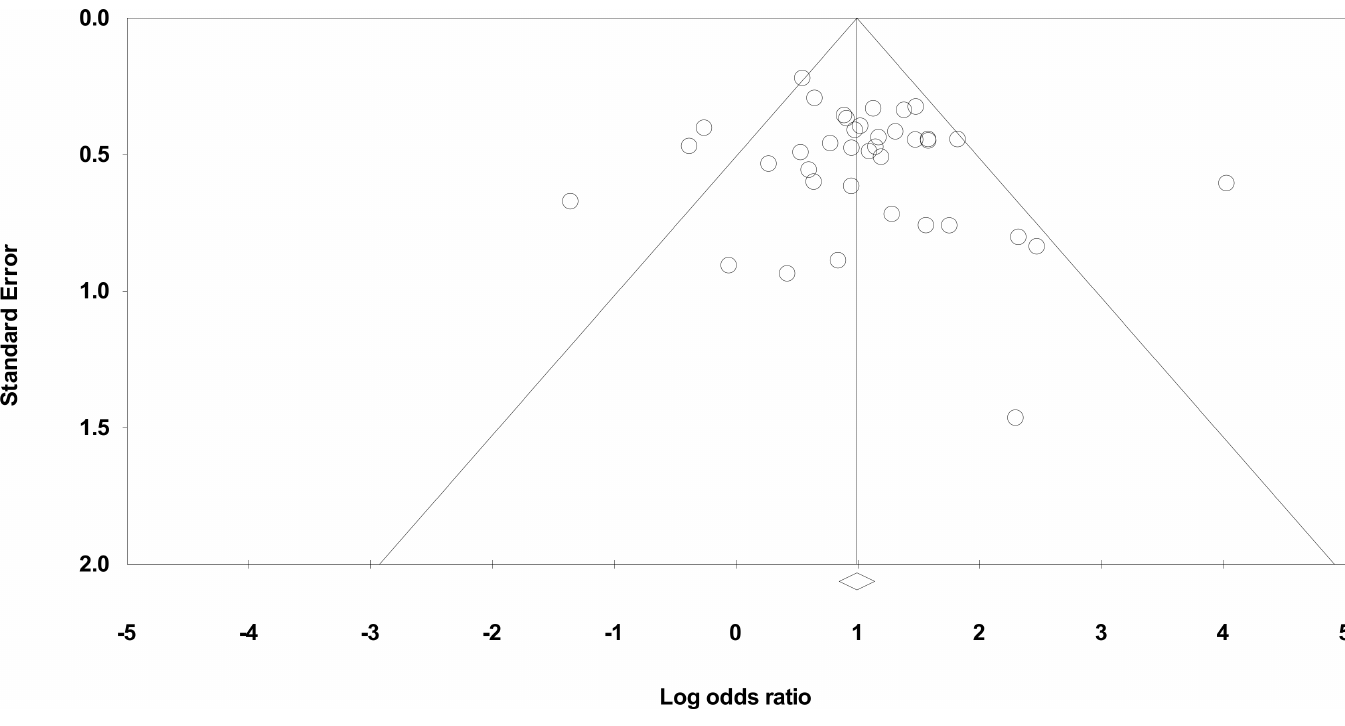
Fig 4. Funnel plot of standard error by log odds